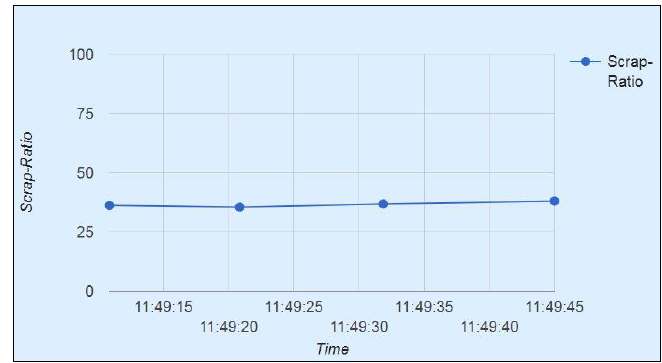
Figure 15. Scrap Ratio KPI of the order produced.